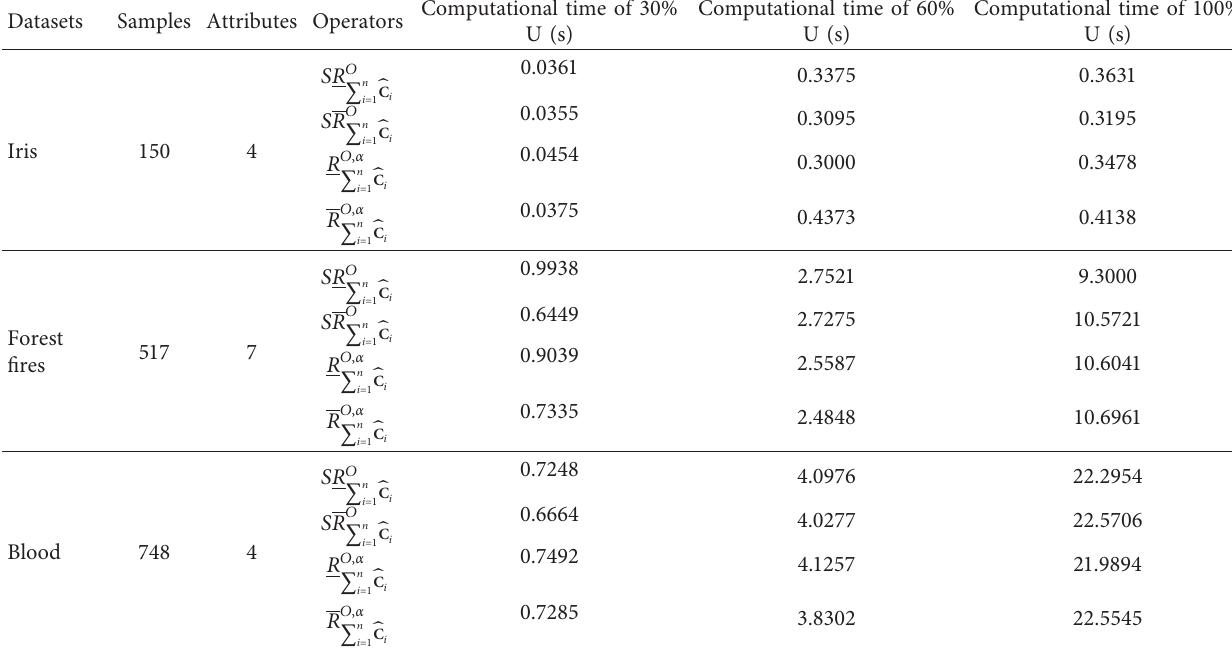
Table 9: Comparison of different approximation operators for some datasets in UCI machine learning repository.